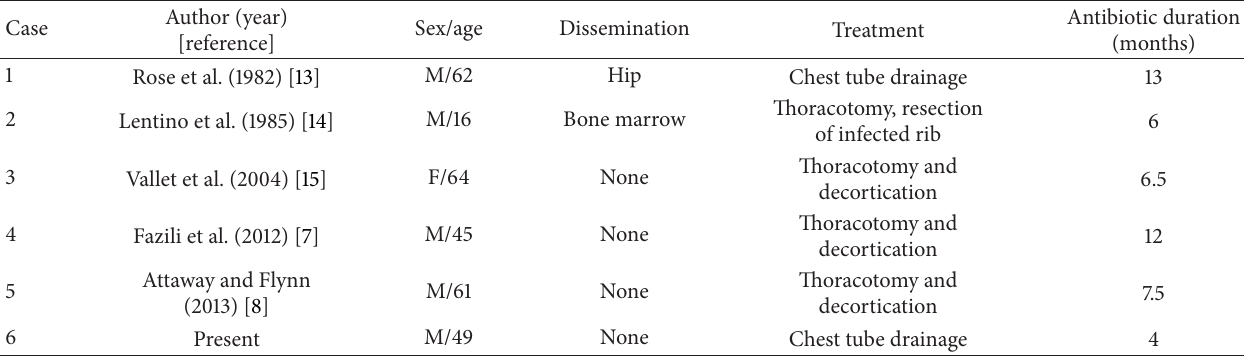
Table 1: Summary of six cases of empyema due to A. meyeri